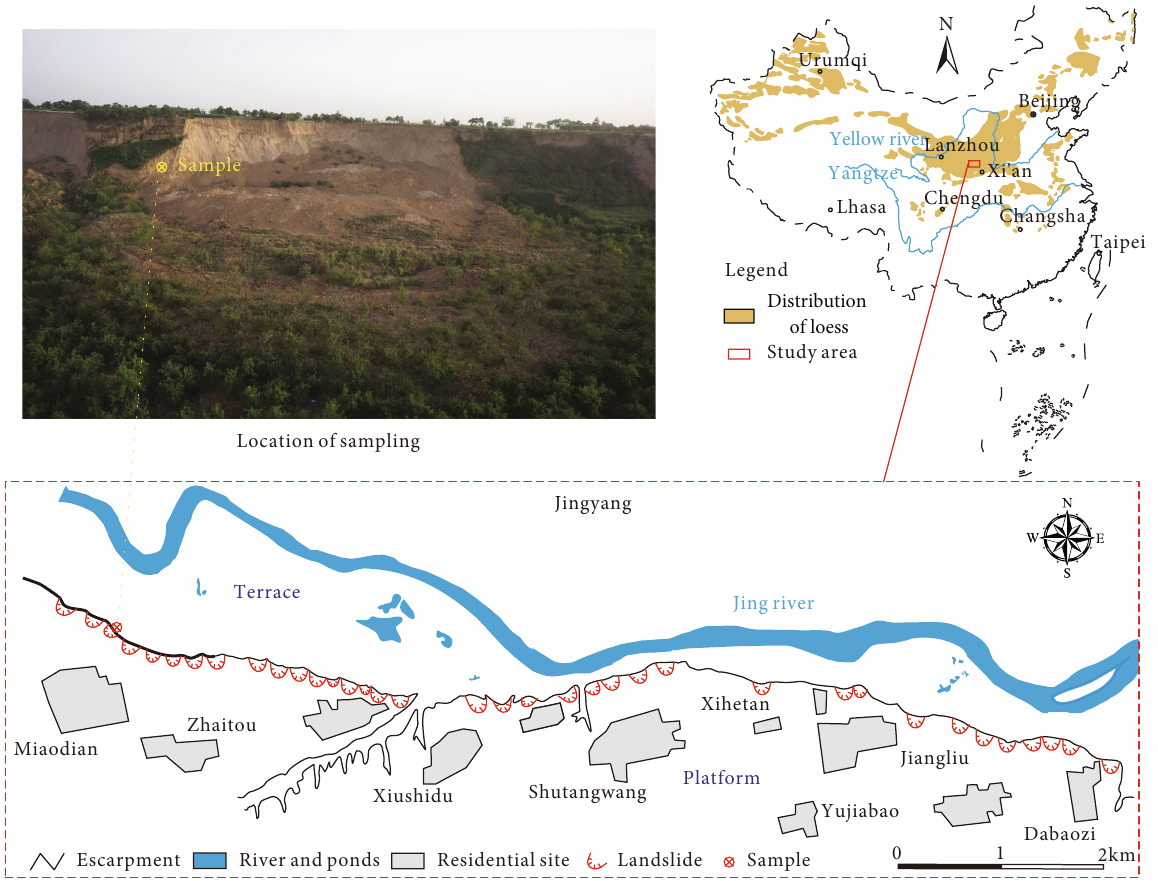
Figure 1: Location of sampling and map of landslides.